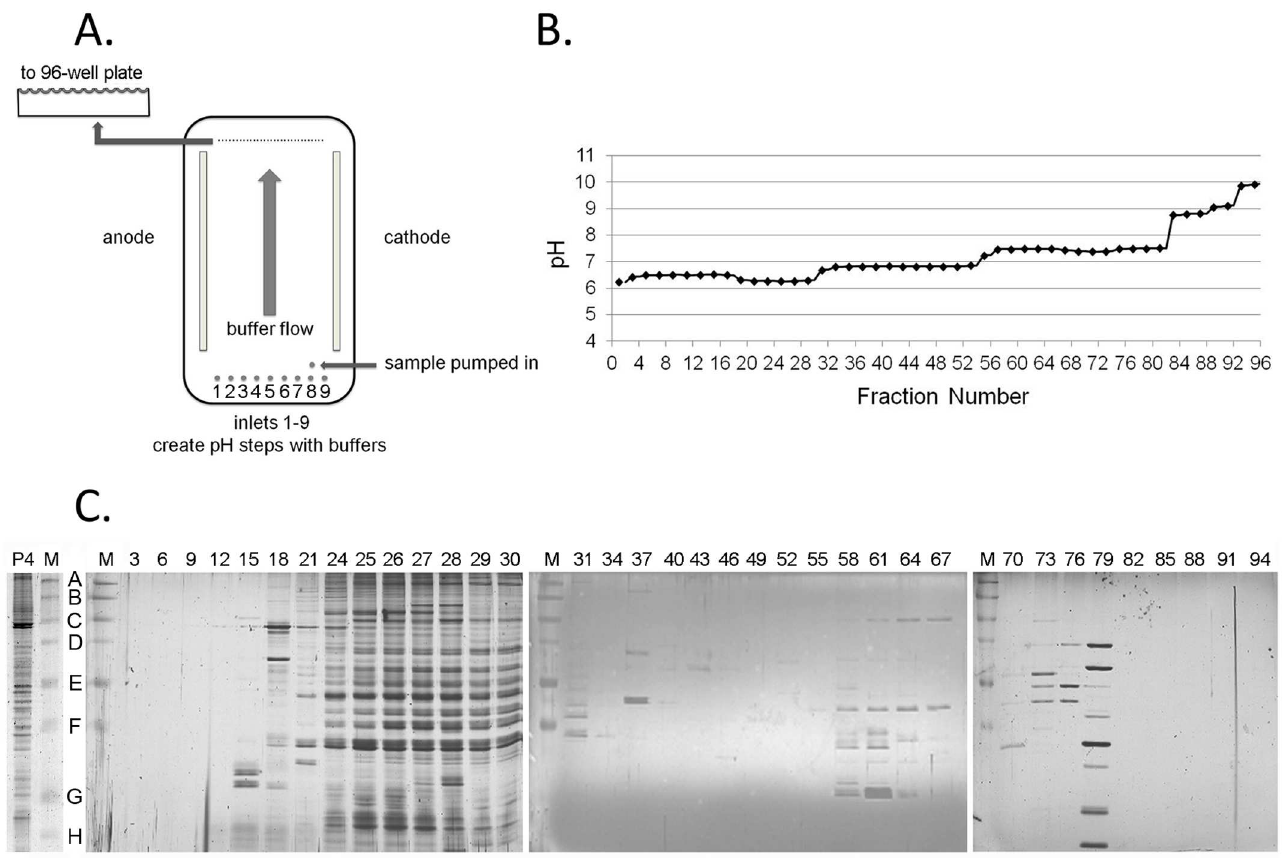
Fig 1. Fractionation of HeLa cell proteins using IZE. (A) Simplifieddiagramof the FFE separation chamber. (B) pH measuredfor every other fraction on the 96-wellplate after protein separation. (C) Separationof fractions from the IZE by denaturinggel electrophoresis and detectionby silver staining.Fraction numbers are labeledon top, and M representsthe mol wt marker. P4 represents the protein before the IZE separation.The molecularmasses of the markers are 250 kDa, 150 kDa, 100 kDa, 75 kDa, 50 kDa, 37 kDa, 25 kDa, and 20 kDa labeledA to H from top to bottom.